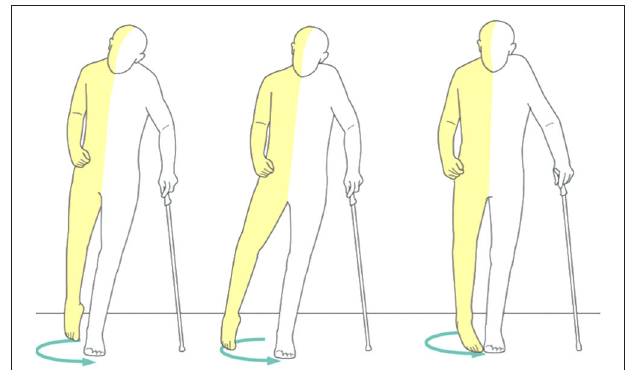
FIGURE 3 | An example of uncorrected post-stroke spastic gait pattern